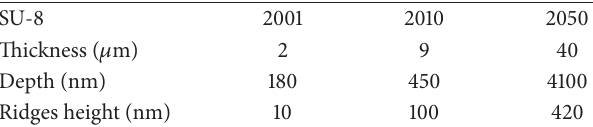
Table 2: Depth profile after PEB for different SU-8 film